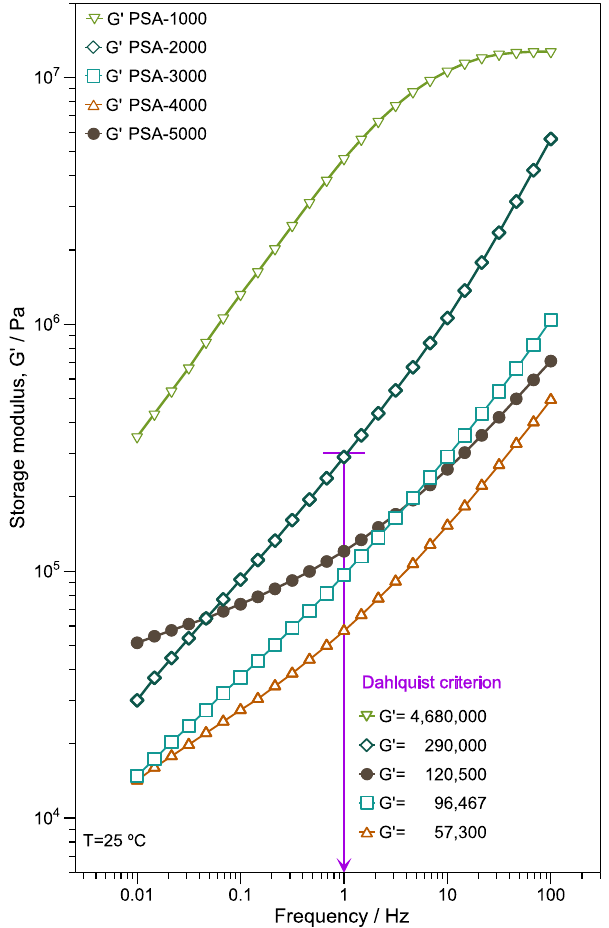
Figure 7. Storage modulus vs. frequency of PSA-1000, PSA-2000, PSA-3000, PSA-4000, and PSA-5000 samples measured at 25 °C.